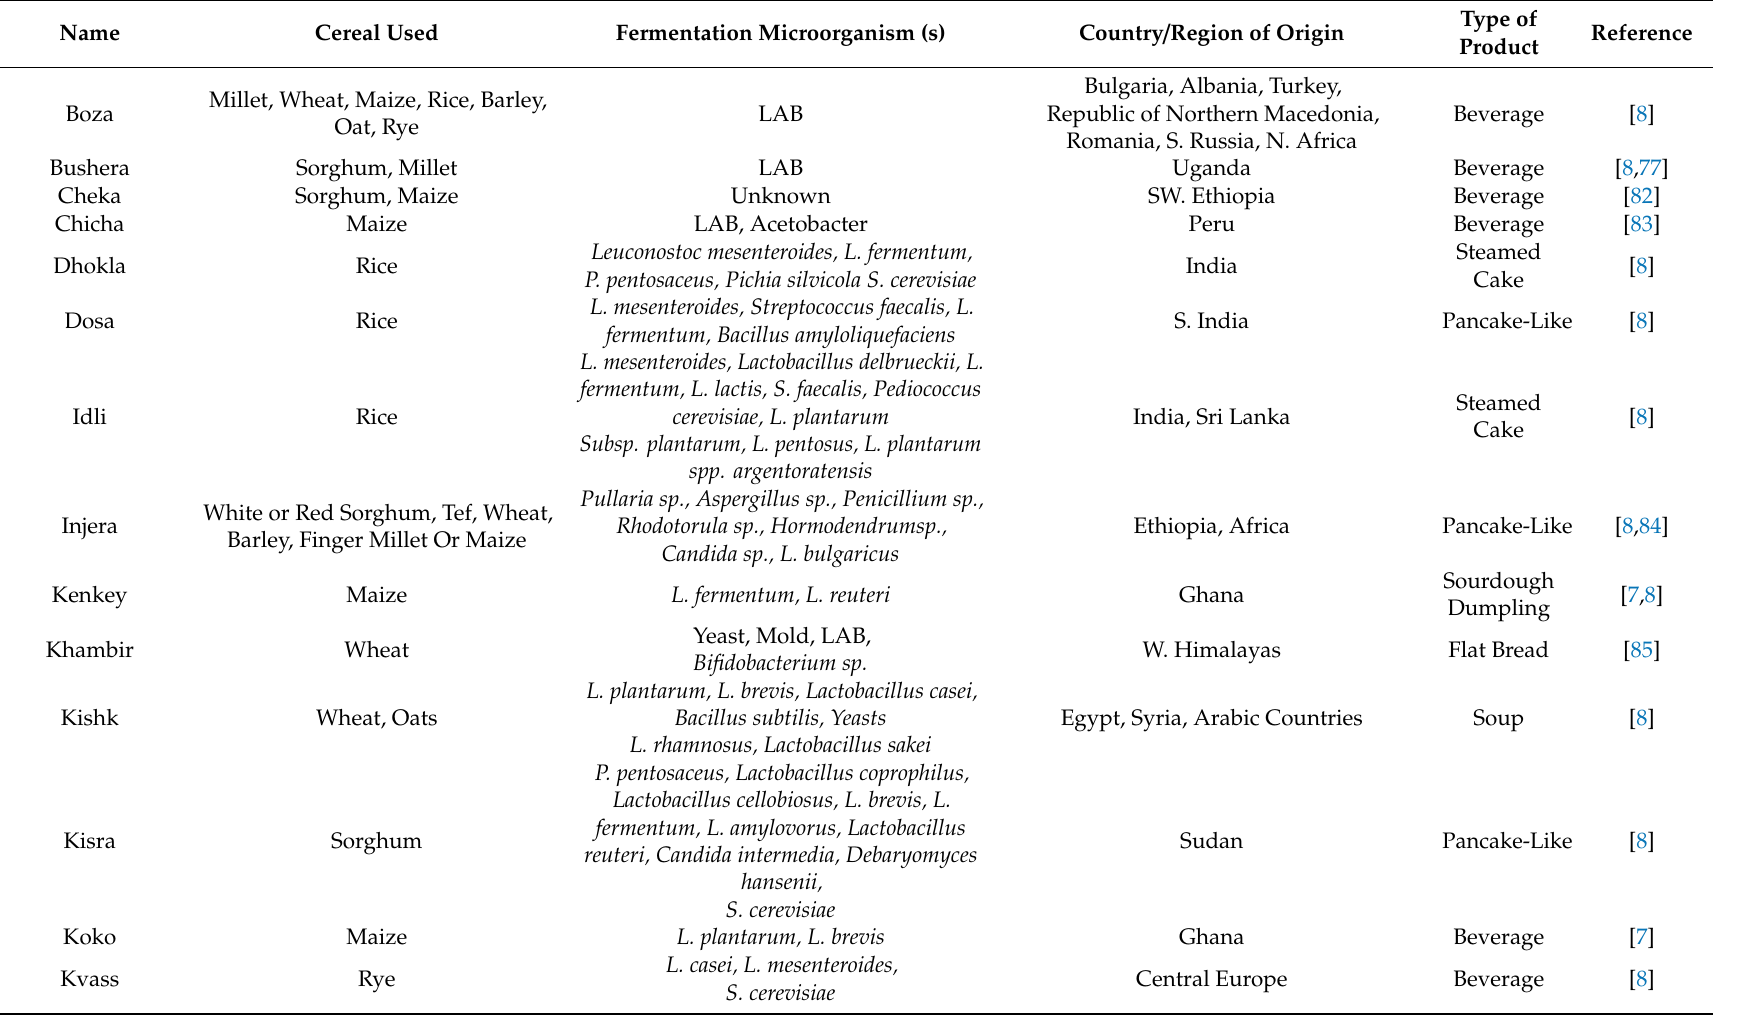
Table 2. The most common traditional cereal-based fermented foods and beverages